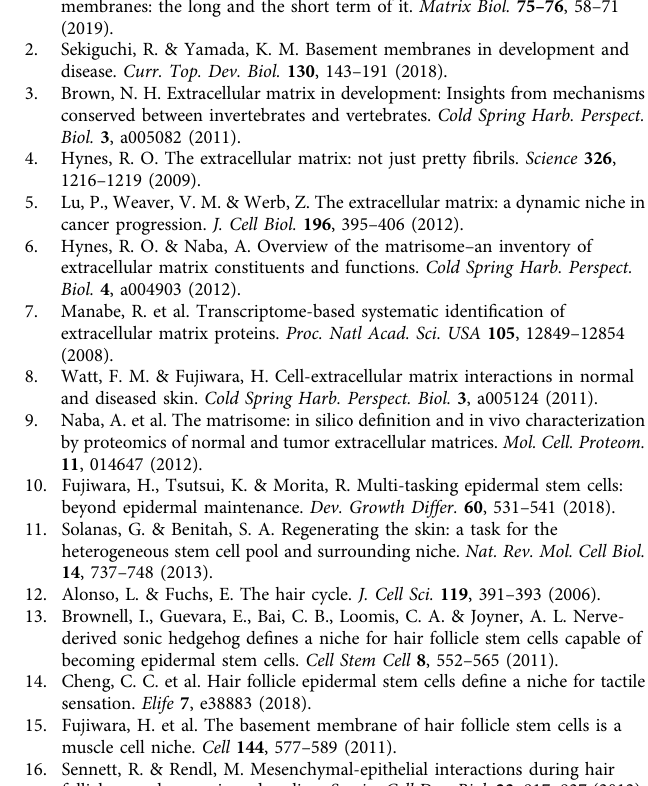
Fig. 9c and Supplementary Fig. 1l, and reproduced with similar results. We show representative micrographs that came from at least two biological replicates.